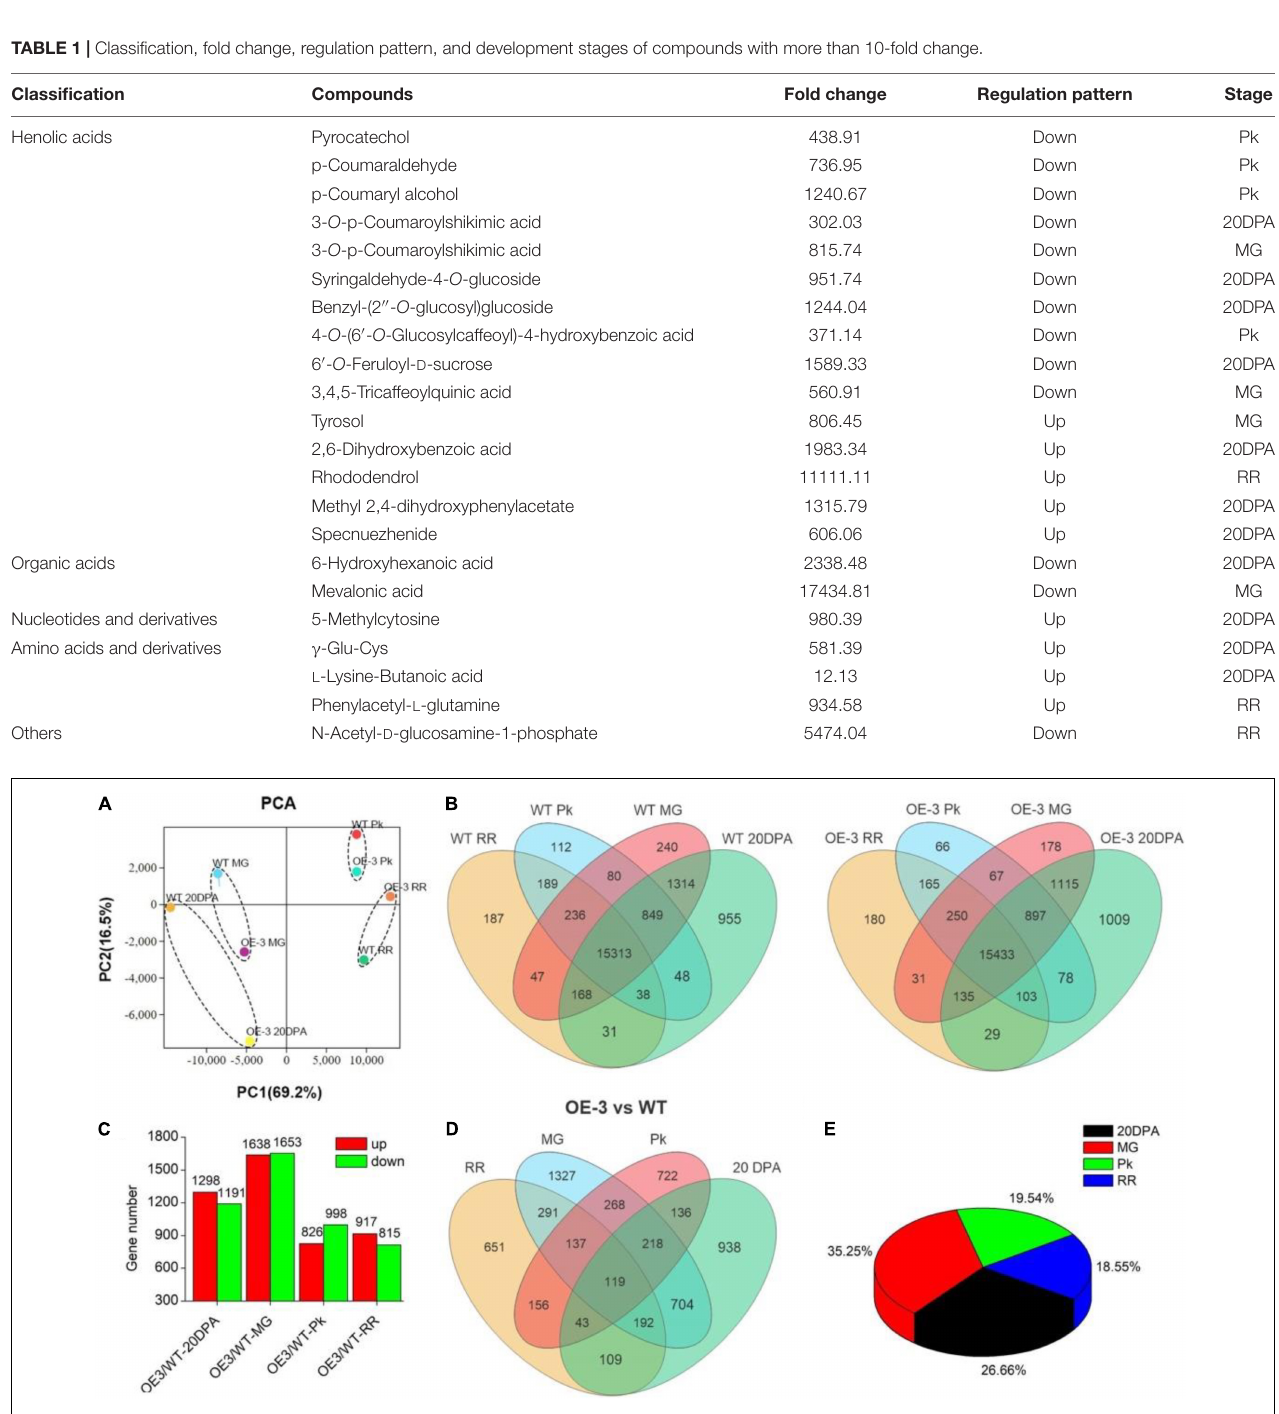
(mws0921), and γ -glu-cys (pme2563) positively